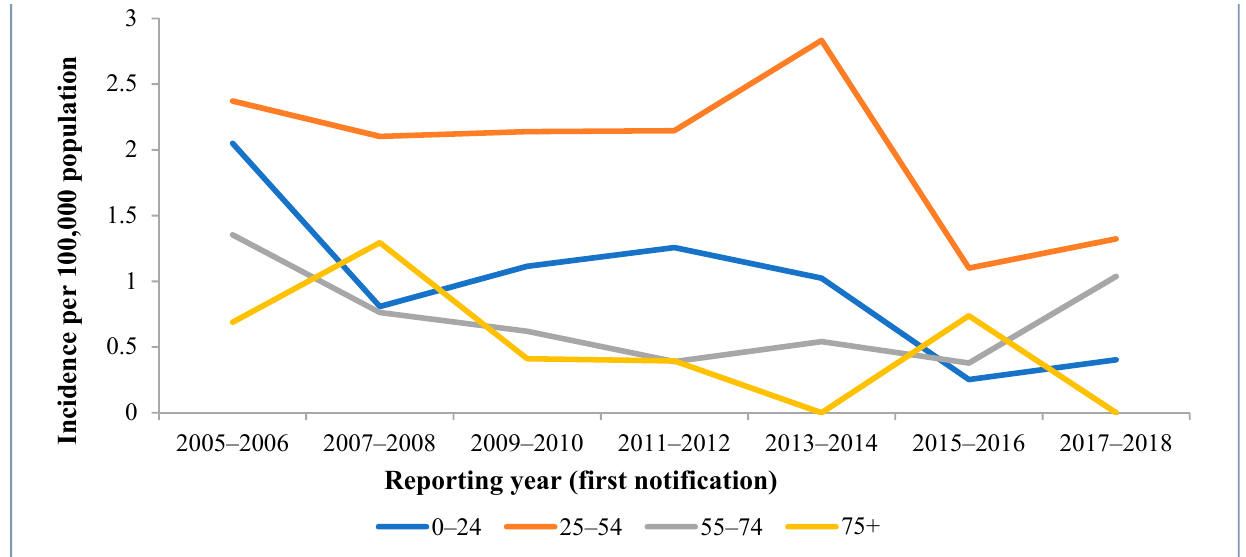
Figure 3. Number and incidence rates of acute hepatitis C virus cases by age group and notification period, Lithuania, 2005–2018. Table 1. Yearly changes of incidence of acute hepatitis C virus infection in different age